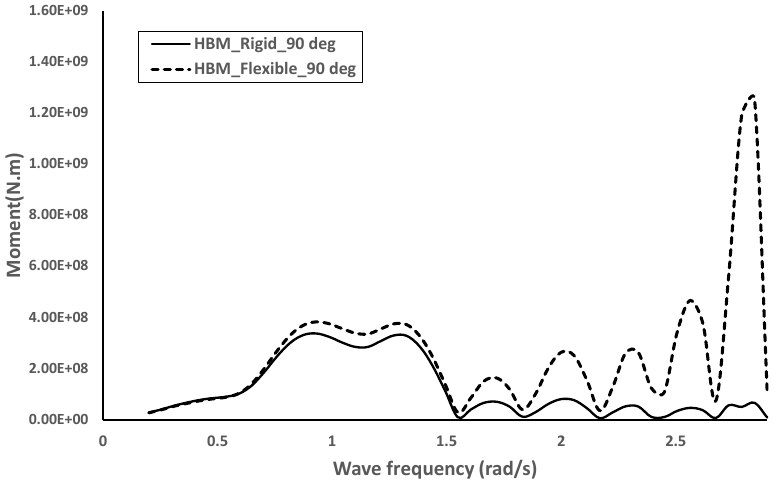
Figure 11. Load transfer function TM (torsional moment).